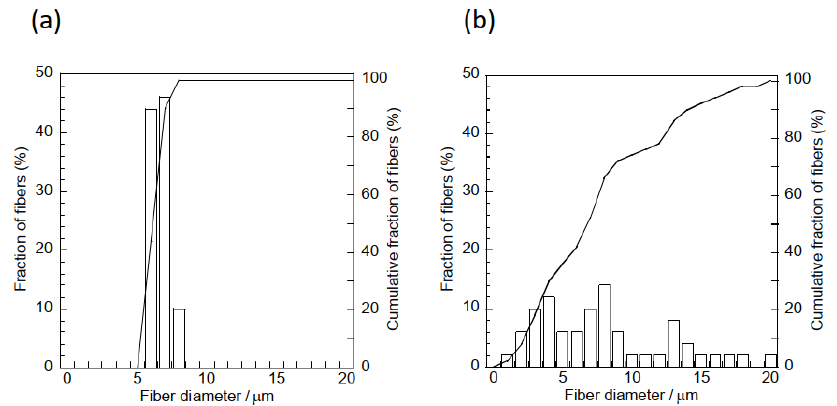
Figure 7. Fiber size distribution curves of the ( a ) polymer and ( b ) composite samples.